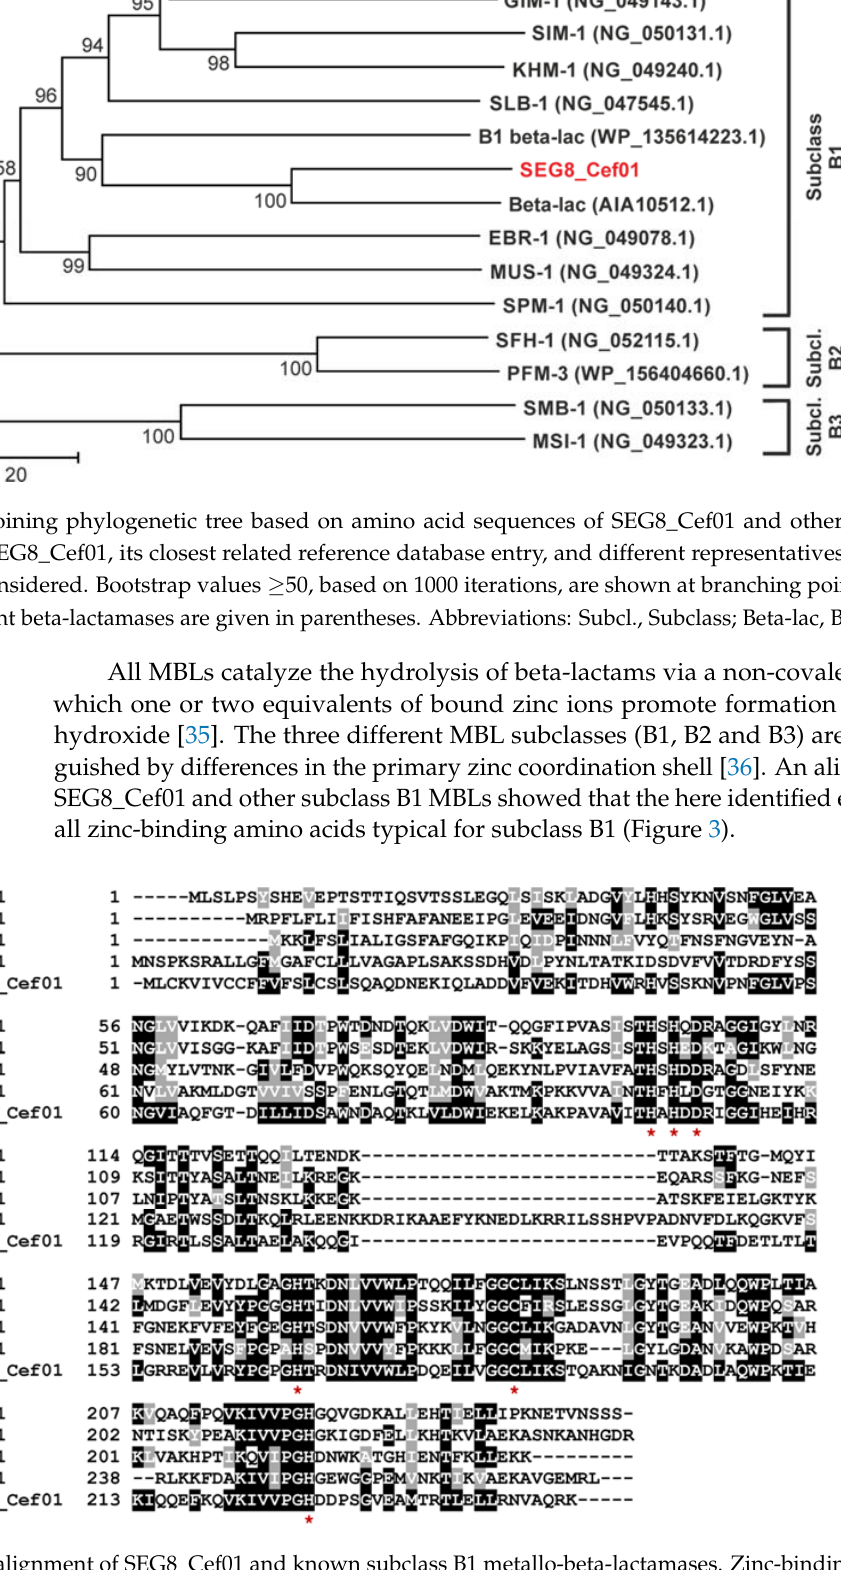
Figure 3. Amino acid alignment of SEG8_Cef01 and known subclass B1 metallo-beta-lactamases. Zinc-binding amino acids are indicated by red asterisks below the specific positions. Accession numbers of the different beta-lactamases are provided in Figure 2.